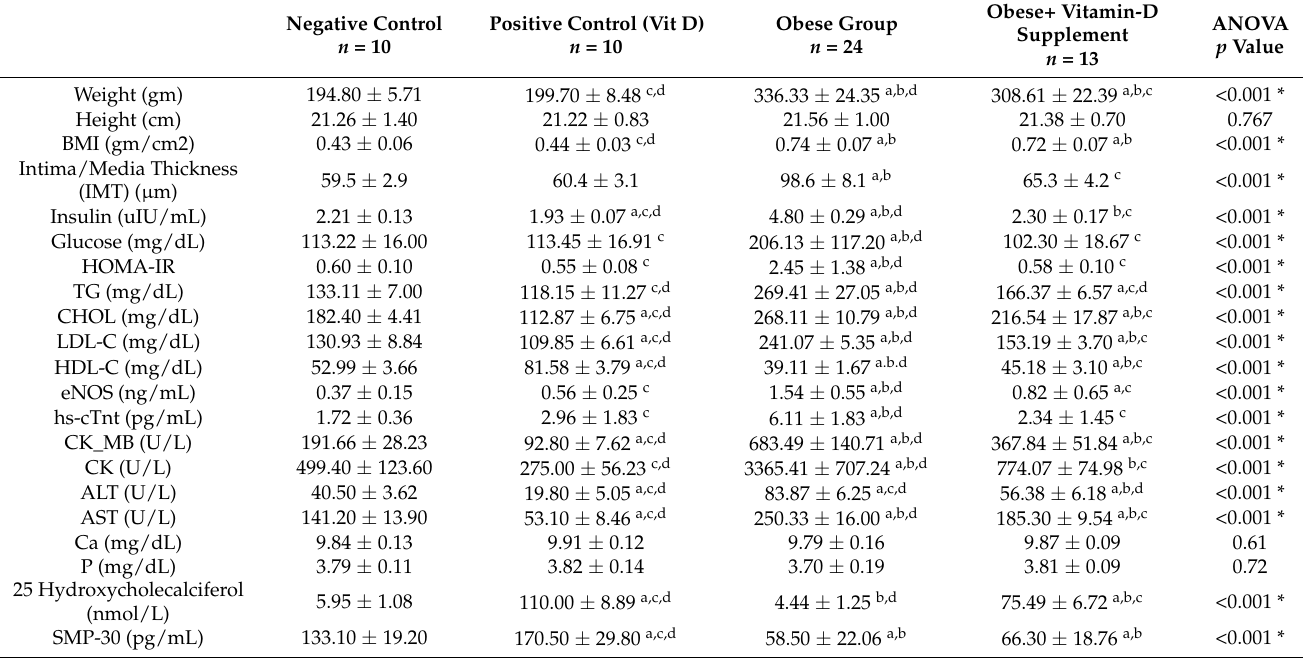
Table 1. The anthropometric and biochemical parameters of all studied animal groups.